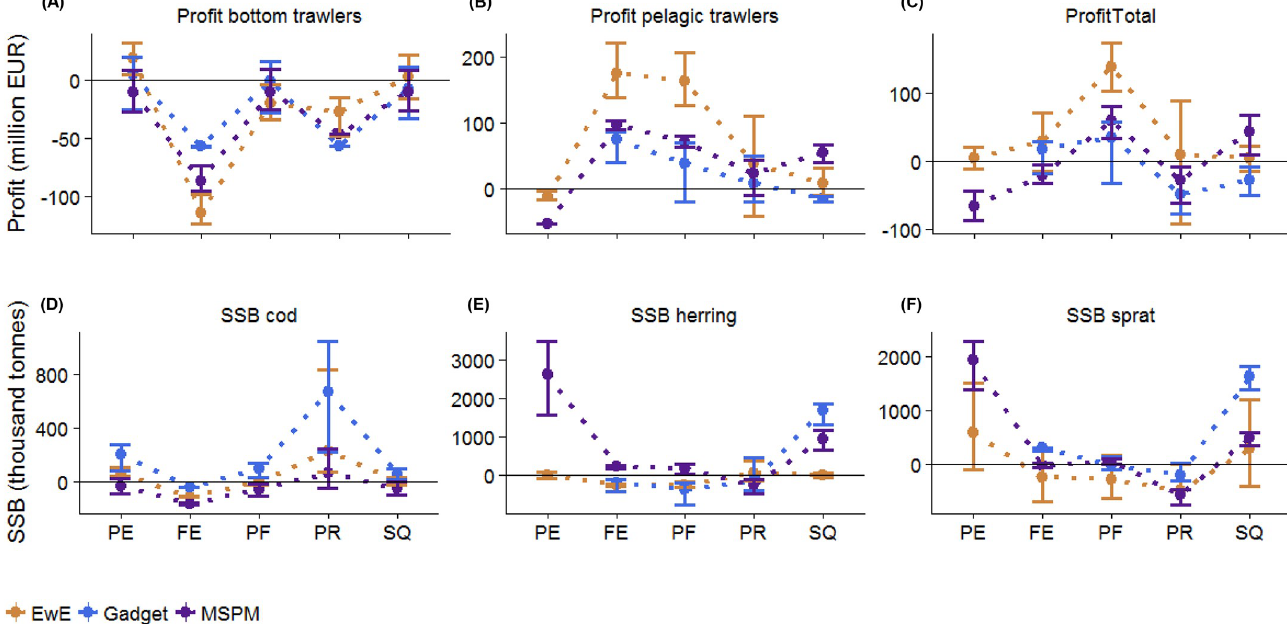
Fig 6. Performance indicators in fisheries management scenarios. Change in yearly profits (2020–2032) of bottom trawlers (A), pelagic trawlers (B) and of the whole fishery (C) and in the spawning stock biomass indicator of cod (D), herring (E) and sprat (F) relative to the average modelled value of 2011–2013 by EwE (brown), Gadget (blue) and MSPM (purple). Dots correspond to the mean and bars to the full range of values. Please note that Gadget does not provide information on clupeid-related indicators in the ‘Piscivore Exploitation’ (PE) scenario (see Methods).